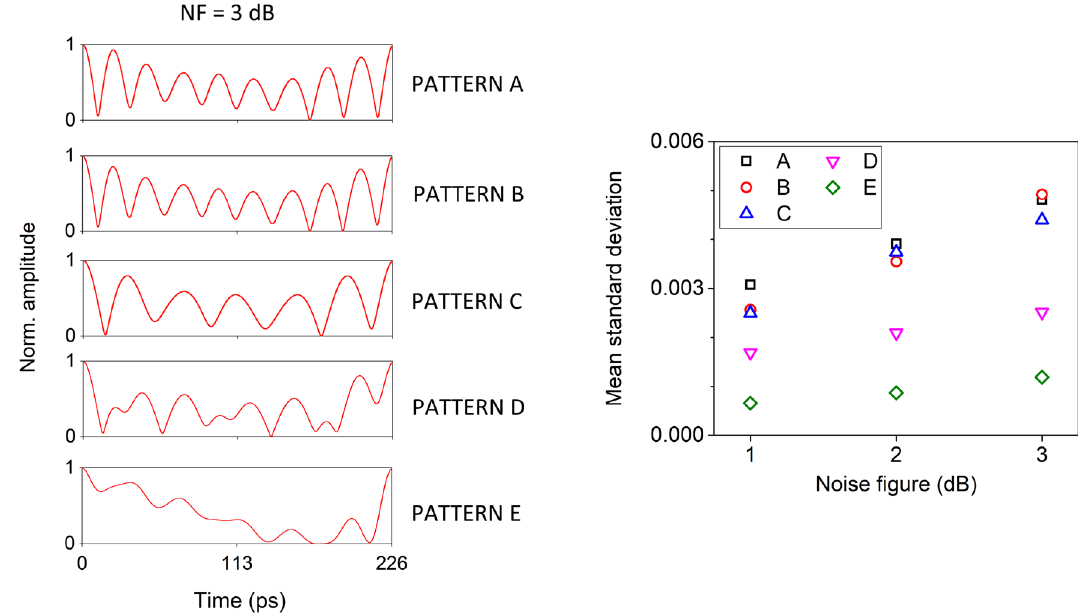
Figure 6. Temporal persistence plots of 100 instances of the repetitive patterns A–E, when the amplification stages suffer from NF =3 dB (left) and mean standard deviation of the persistence plots for different levels of NF (right). The temporal persistence plots are obtained from timeseries with a total duration of 50,000 patterns, including the first and the last